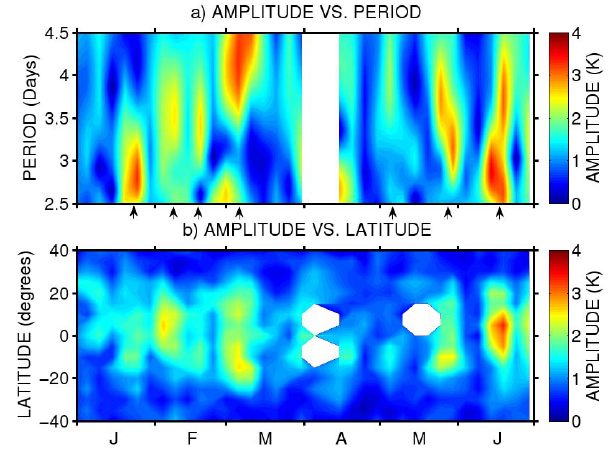
Fig. 8. Amplitude of E1 waves derived from Aura MLS tempera- ture measurements at a height of 97km as a function of (a) wave period at the latitude of Ascension Island (8 ◦ S) and (b) latitude. In (b) , the amplitudes are averaged over wave periods of 2.5–4.5 days. The data cover the interval January–June 2005. The arrows on (a) indicate the times at which large amplitude UFKW events were observed over Ascension Island in Fig.